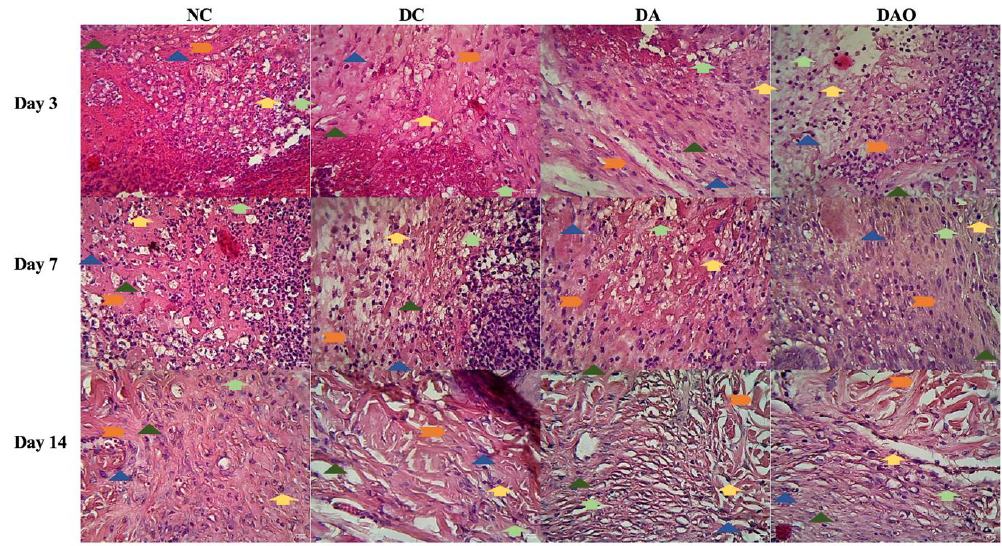
Figure 4. Histology of wound parameter including neutrophils — ; Macrophages— ; Fibrocytes— ; Fibroblasts—